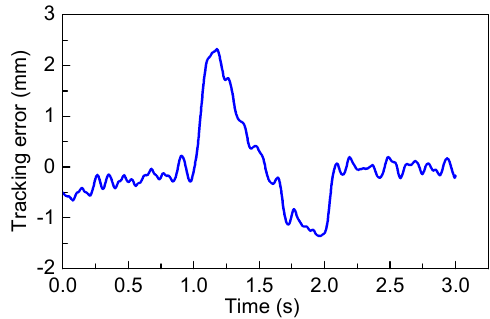
Figure 9. Displacement tracking using backstepping controller with tracking differentiator and nonlinear disturbance observer (BSTDNDO).